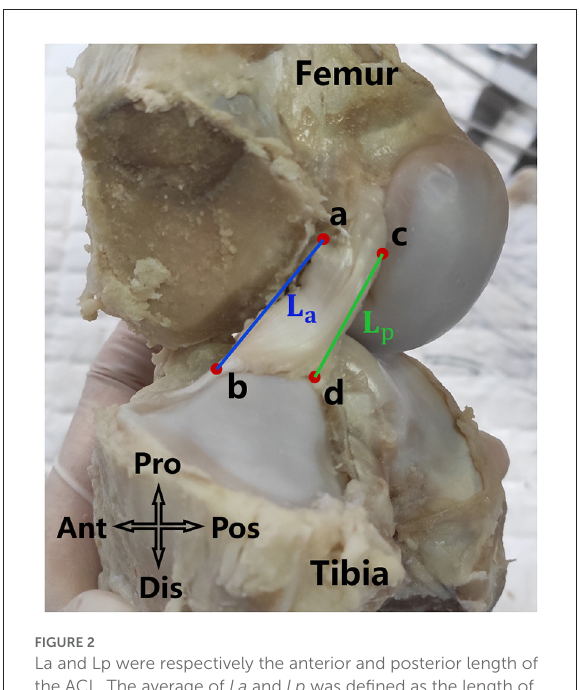
FIGURE2 La and Lp were respectively the anterior and posterior length of the ACL. The average of La and Lp was defined as the length of the